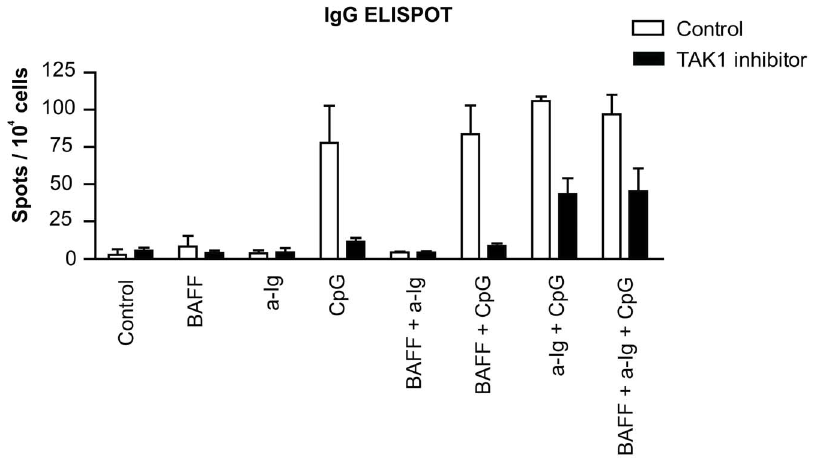
Figure 7. Synergistic stimulation of IgG producing plasma cell differentiation by anti-Ig and CpG ODN in the presence of TAK1 inhibitor. Purified human blood B cells (10 5 cells/well) were cultured with anti-Ig (2.5 m g/ml), BAFF (100 ng/ml) and CpG (0.5 m g/ml) as indicated below the figure for 4 days in the presence of IL-2 (50 ng/ml) and IL-10 (50 ng/ml). Numbers of IgG producing plasma cells were determined by ELISPOT assay. Spot numbers in the presence of vehicle (white bars) and spots in the TAK1 inhibitor treated samples (black bars) are shown. Means